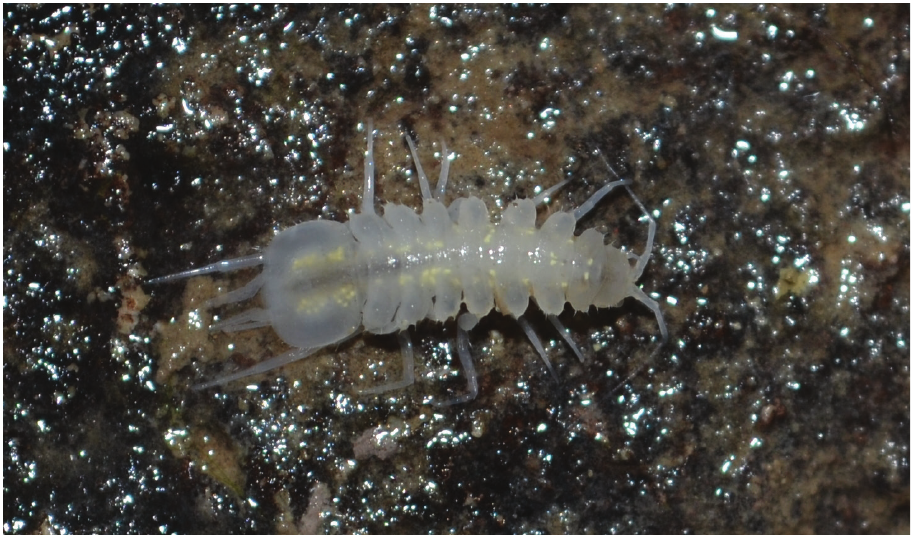
Figure 2. Habitus of Asellus ismailsezarii sp. nov. (Female AS1). The photo shows a specimen exposed to air after the stone it was under had been turned over. Body length is 8.6